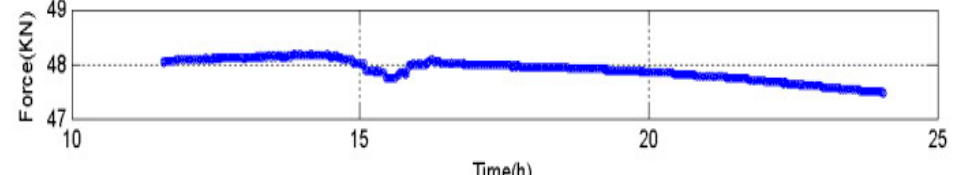
Figure 10. The pretightening force of the bolt when the initial force is 45% of the yield strength and the excitation frequency is 6 Hz.